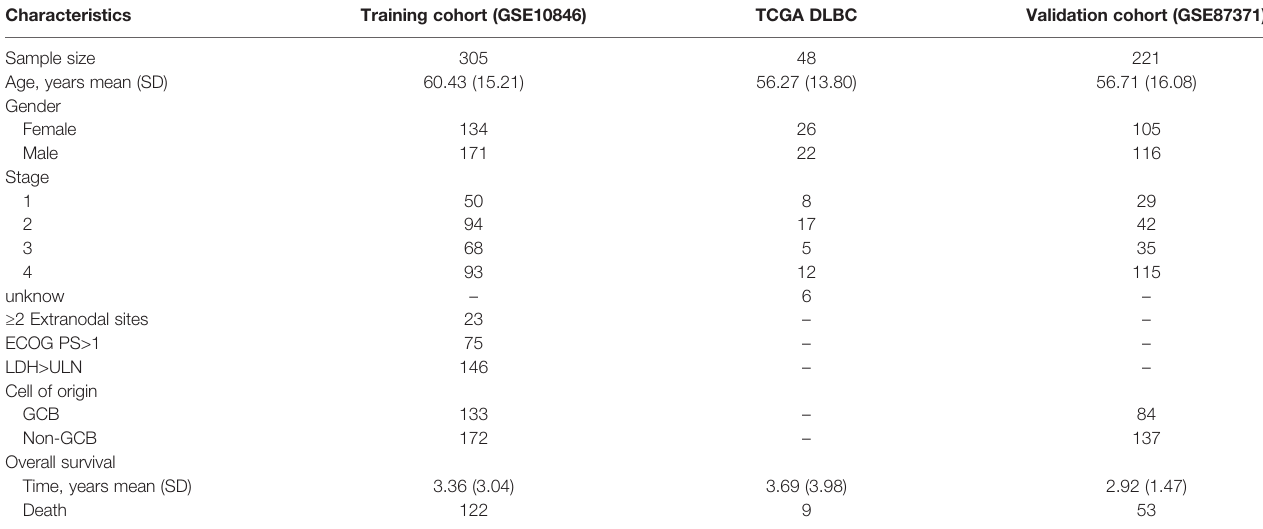
TABLE 1 | The clinical characteristics of the GEO and TCGA datasets.